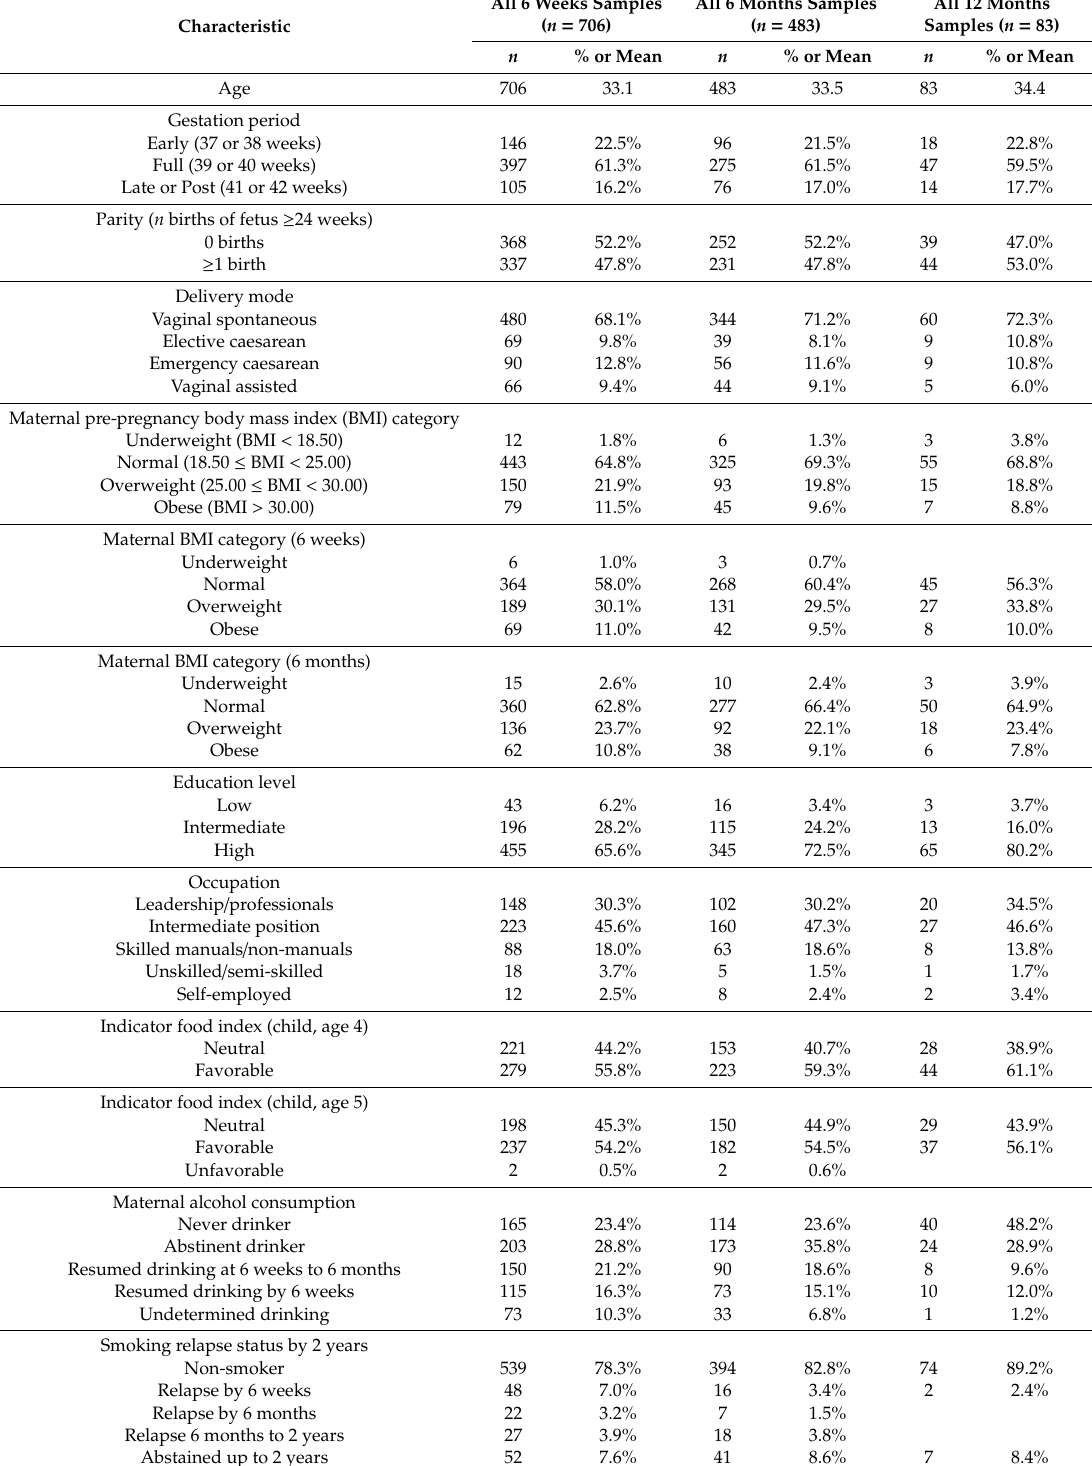
Table 1. Characteristics of the lactating women included in the Ulmer SPATZ Health